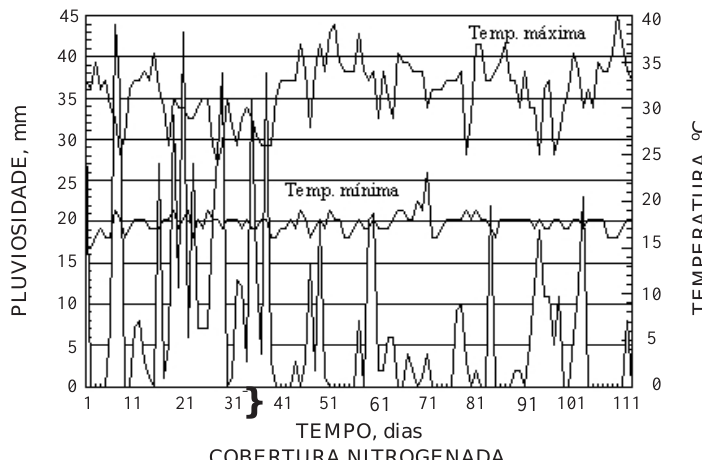
NITROGENADATEMPO, COBERTURA Figura 1. Distribuição da pluviometria e temperaturas máximas e mínimas durante o período experimental.